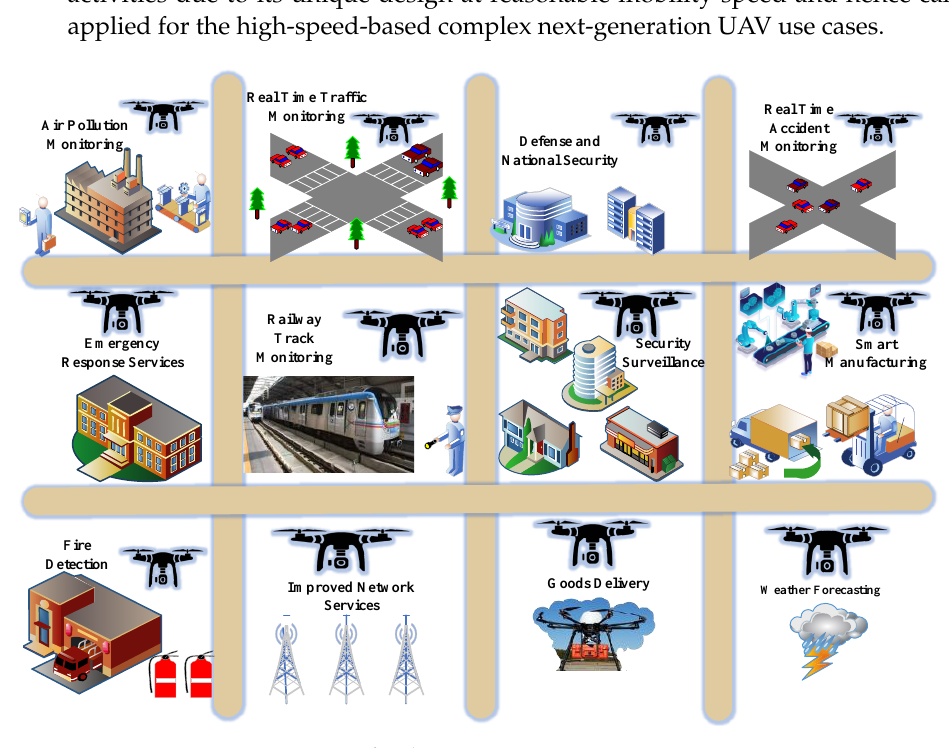
Figure 1. Next-generation use cases for drones.